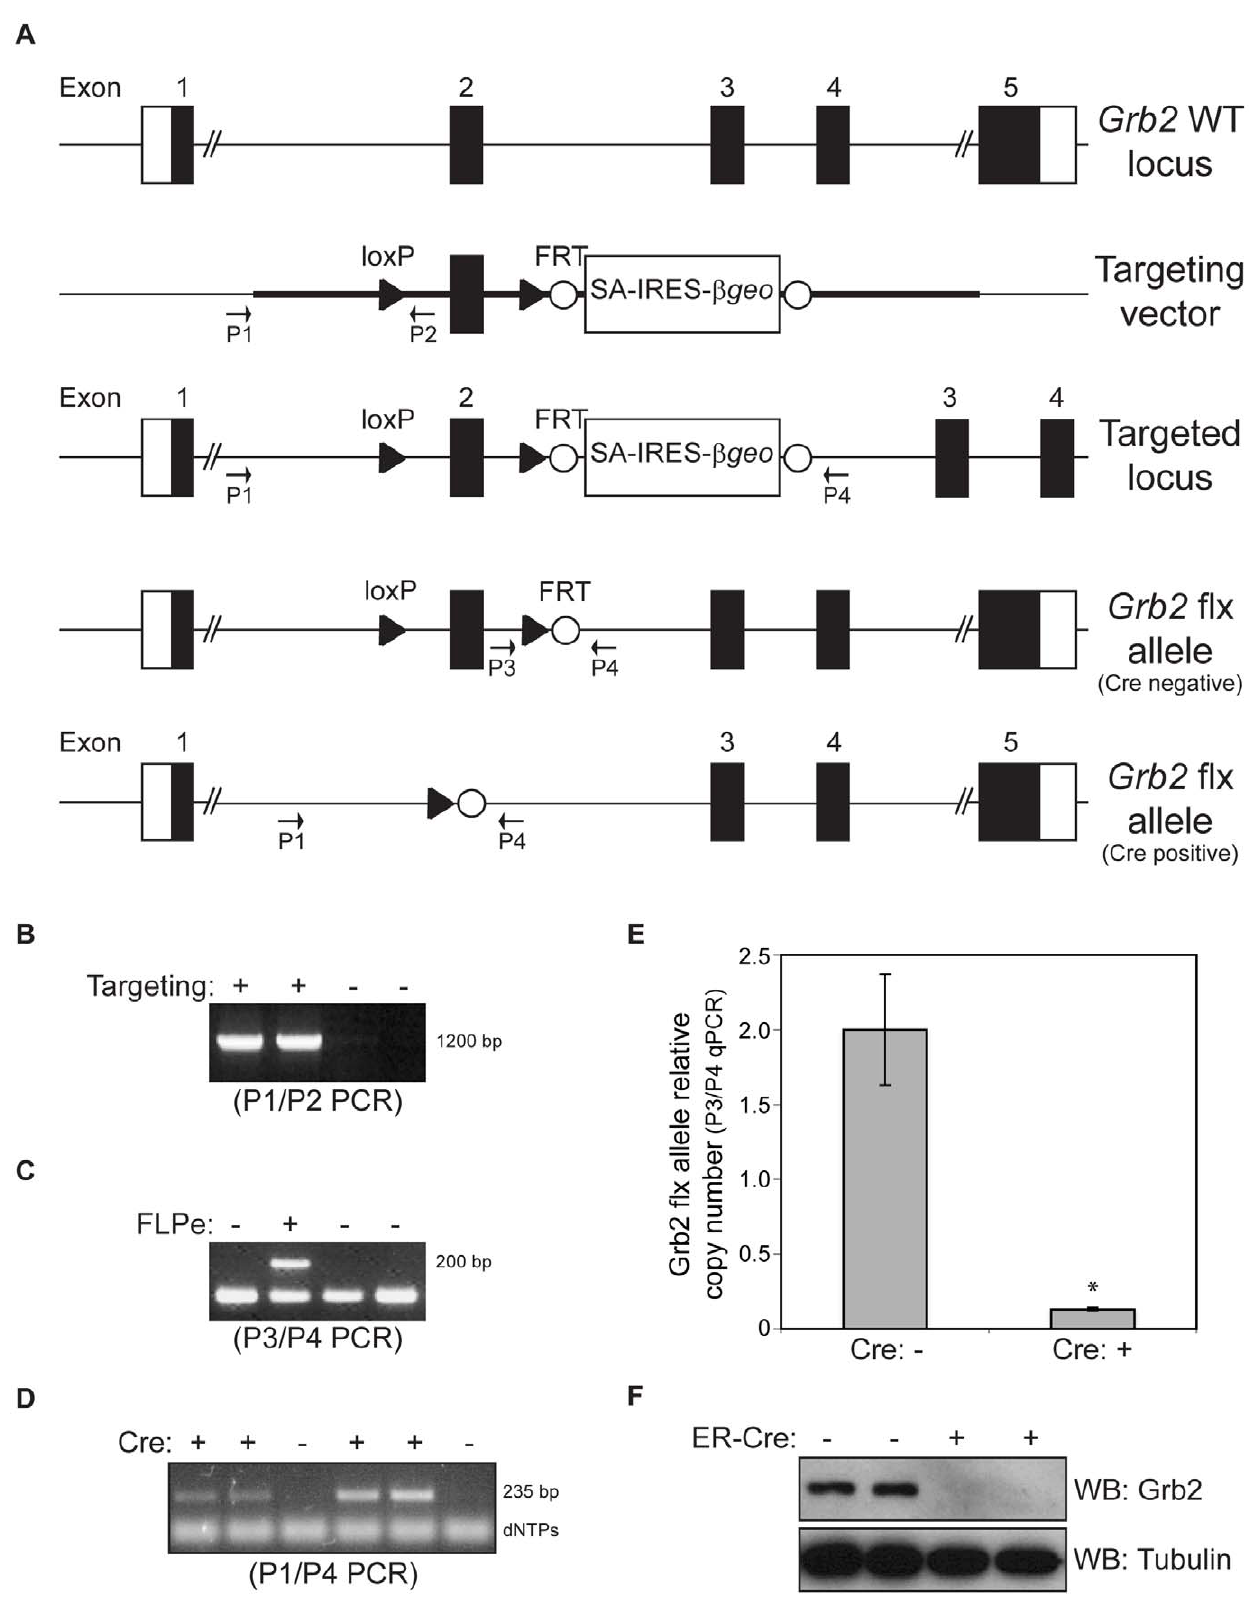
Figure 2. Conditional inactivation of the Grb2 gene in mice. (A) Schematic representation of the Grb2 locus targeting strategy and the resulting conditional Grb2 flx allele. LoxP sites are represented with white triangles and FRT sites with white circles. Genotyping primers P1 to P4 are shown. (B) Example of 2 positive ES clones targeted at the Grb2 locus, as judged from a positive P1/P2 PCR product of 1200 bp. (C) Example of a